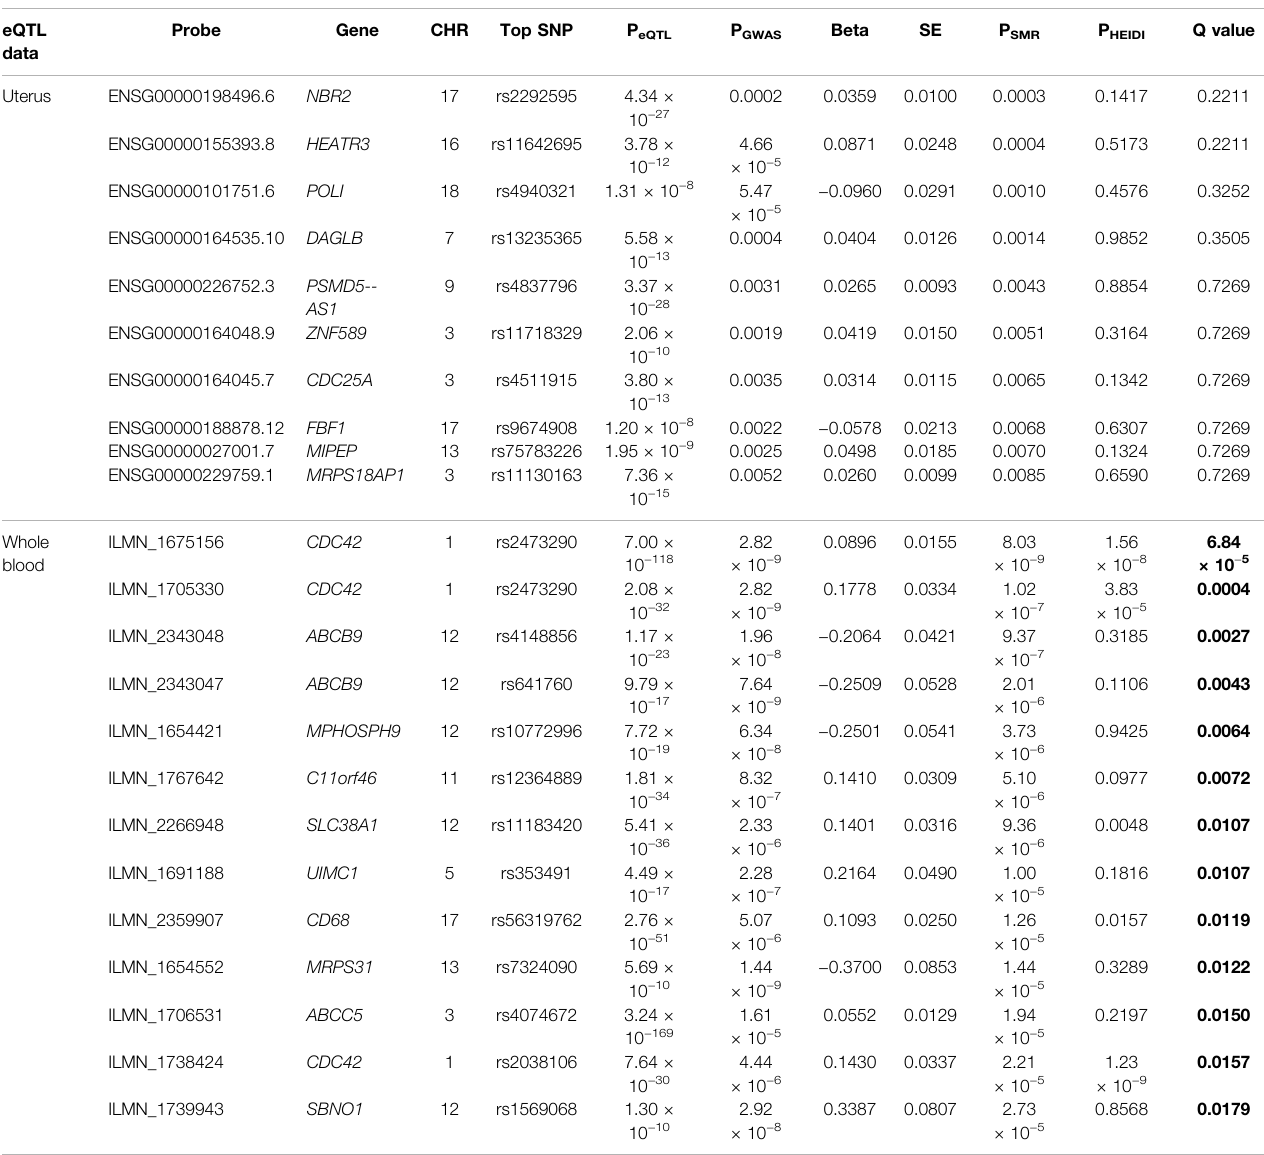
TABLE 2 | The top hit probes identi fi ed in SMR analysis*. eQTL